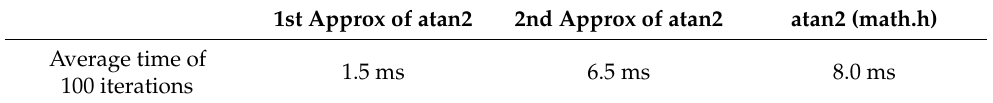
Table 8. Experimental result on actual MCU (PIC18F2580@4MHz internal